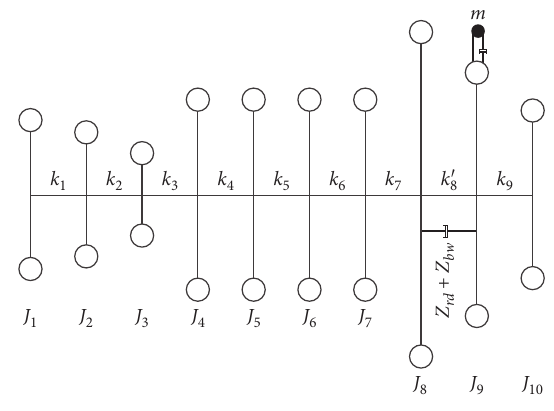
Figure 4: Torsional vibration model of power transmission under the idling condition.